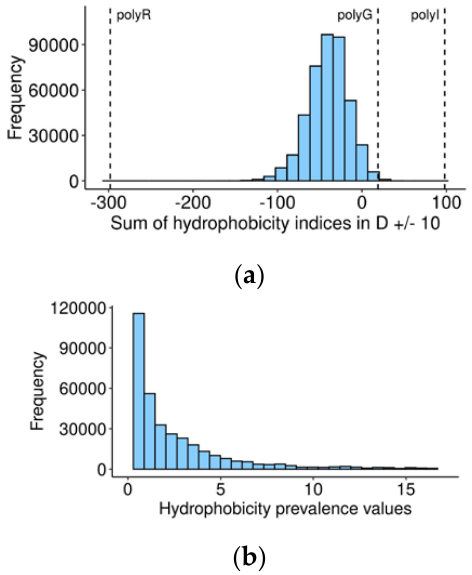
Figure 3. Hydrophobic properties of vertebrate cleavage sites. ( a ) Distribution of the sums of hydrophobicity indices (HI) for the 20 amino acids surrounding P1 aspartate in all caspase substrates. PolyR: polyarginine-20 (HI = − 298.4), hydrophilic limit of the scale. PolyI: polyisoleucine-20 (HI = 98.4), hydrophobic limit of the scale. PolyG: polyglycine-20 used as a reference to designate a borderline between hydrophobic and hydrophilic peptides. It was chosen because its HI (0.94) is the closest to the median HI among all 20 amino acids (0.4). ( b ) Distribution of hydrophobicity prevalence values in all caspase substrates, calculated as described in the